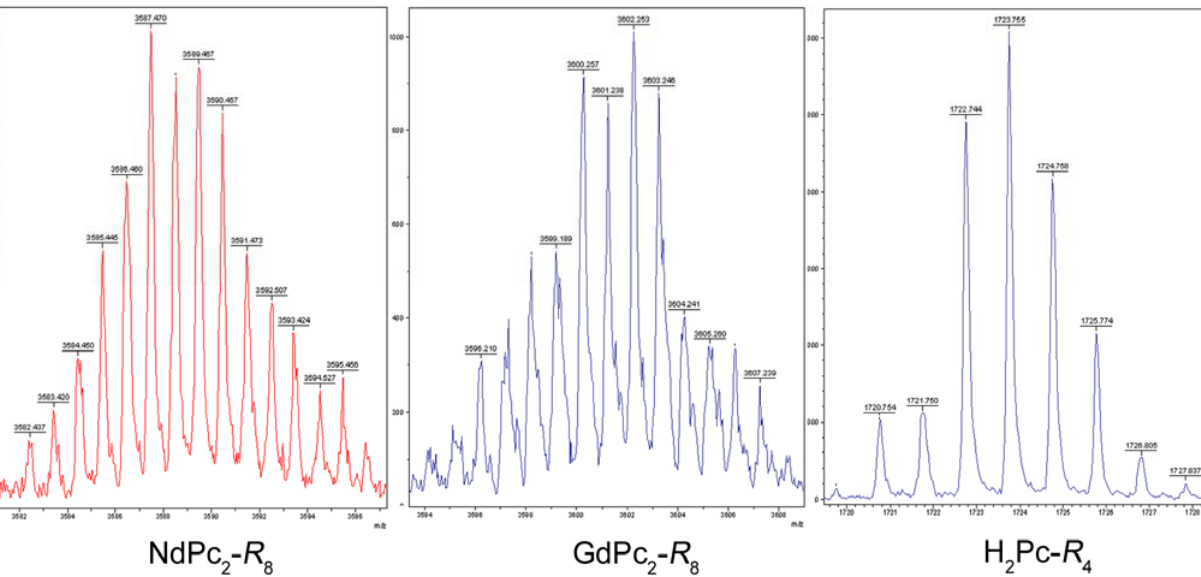
- R , GdPc - R and H Pc- R have been 2 8 2 8 2 4